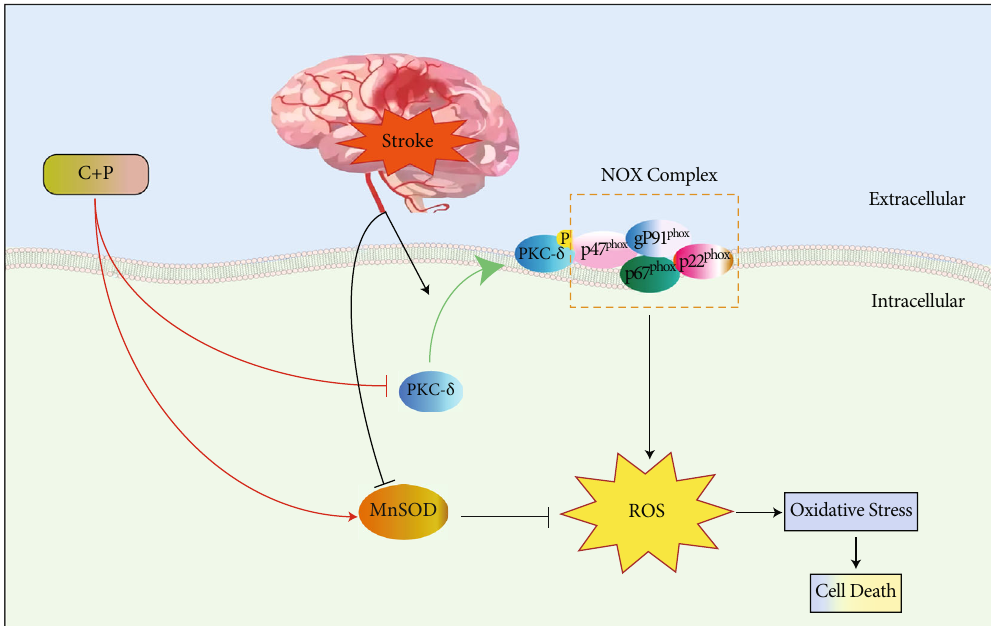
Figure 8: Schematic illustration of neuroprotection of C+P through the PKC- δ /NOX/MnSOD pathway. After I/R, PKC- δ translocated to the cell membrane is phosphorylated and activated. PKC- δ interacted with p47 phox which facilitates the activation of NOX. Moreover, MCAO also induced the elevated expression of NOX subunits gp91 phox , p47 phox , p67 phox , and p22 phox , resulting in NOX activation. NOX activation further increased ROS production and oxidative stress. Additionally, MnSOD expression is repressed after stroke. C+P suppressed both PKC- δ and NOX activation and promoted MnSOD expression, resulting in the reduced ROS production and oxidative